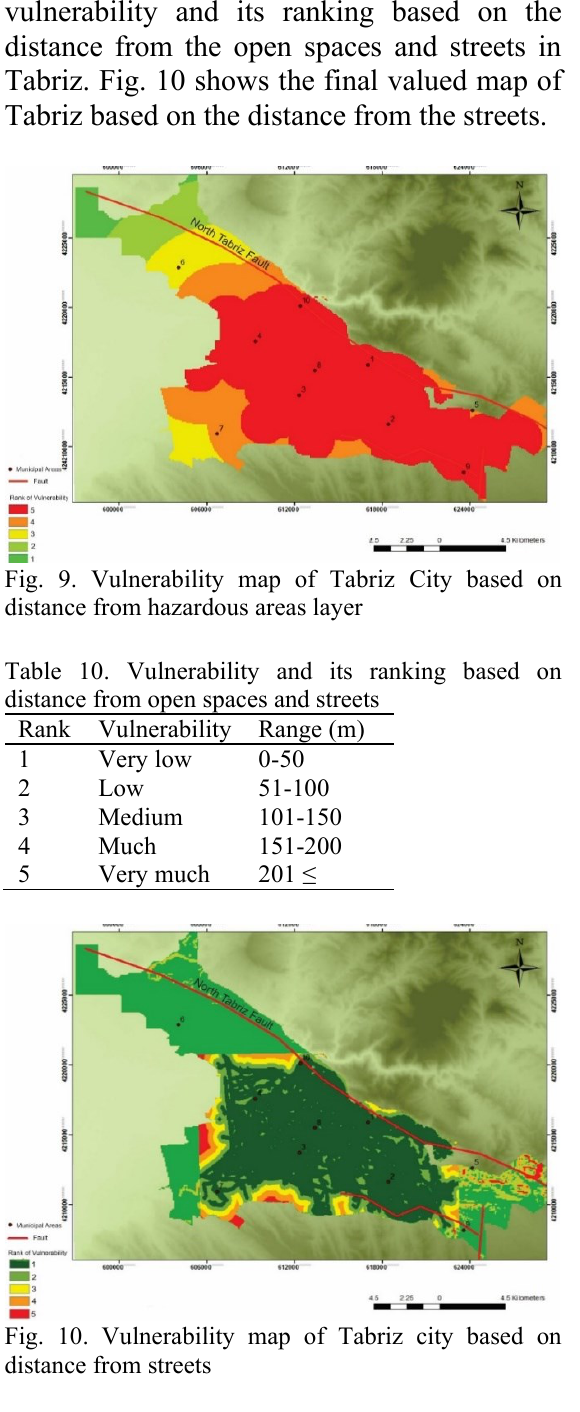
Fig. 10. Vulnerability map of Tabriz city based on distance from streets